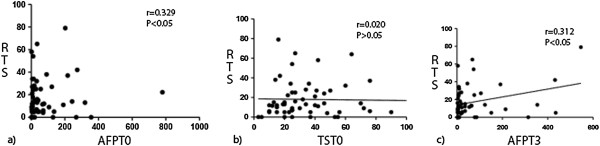
Correlations between studied variables and recurrent tumor size in all patients. (a) Pre-treatment serum AFP level (AFPT0) and recurrent tumor size (RTS) were significantly correlated (r = 0.329 P < 0.05). (b) Recurrent tumor size (TST0) and RTS were not correlated (r = 0.020, P > 0.05). (c) The 3-month post-treatment serum level (AFTT3) and recurrent tumor size were significantly correlated (r = 0.312, P < 0.05).